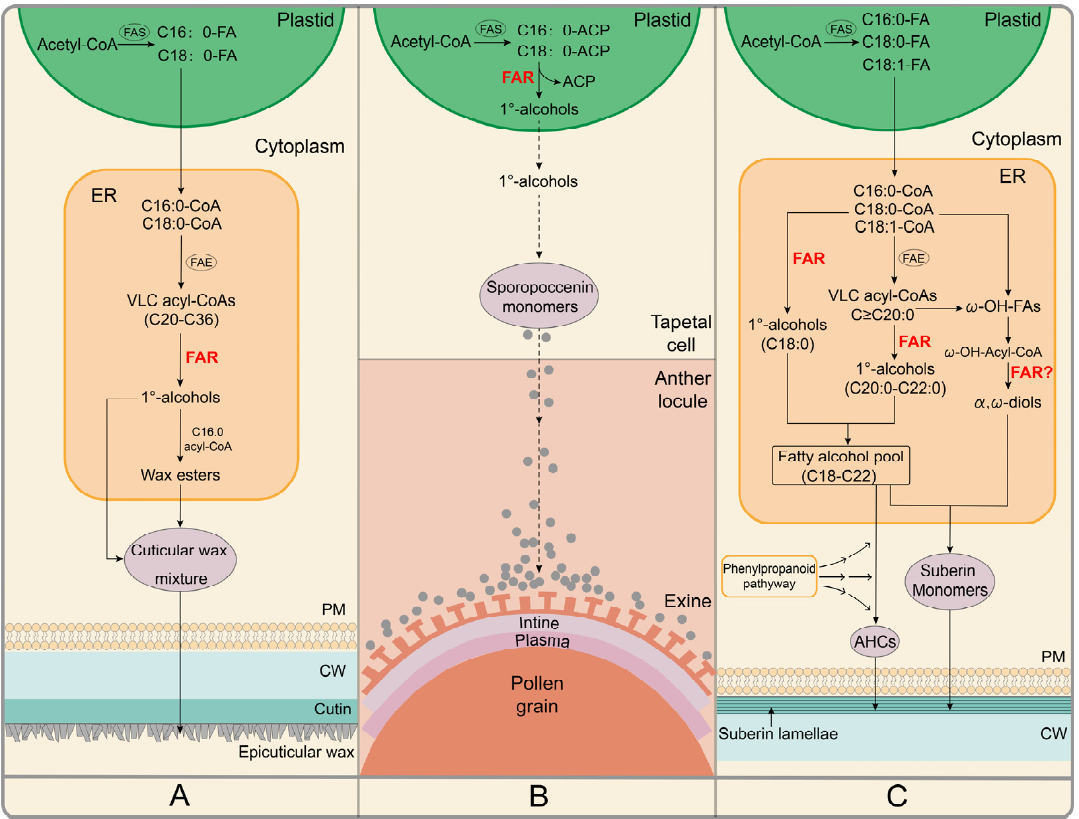
Figure 3. Pathways of FARs involved in lipid metabolism in the plant kingdom. ( A ) ER-Localized FARs are involved in the accumulation of cuticular waxes. The biosynthesis of waxes begins with C16 or C18 de novo fatty acid synthesis in the plastid. Then, utilizing C16 and C18 acyl-CoAs as substrates, the fatty acid elongase (FAE) complex performs a reiterative cycle to synthesize saturated VLCFAs. These VLCFAs are further modified into primary alcohols and wax esters. ( B ) Plasmid-Localized FARs are involved in sporopollenin biosynthesis. Acyl-ACPs synthesized de novo in the plastid are reduced by FAR to produce fatty alcohols. This product could then be exported to the anther locule by an unknown mechanism where it polymerizes at the surface of the microspore. ( C ) ER-Localized FARs are involved in the suberin and suberin-associated wax production. De novo fatty acid synthesis occurs in the plastid. Fatty acyl elongation occurs via the FAE complex producing VLCFAs. FARs catalyze acyl reduction to produce suberin monomer primary alcohols and α , ω -diols. Coumaric, caffeic, and ferulic acids produced by the phenylpropanoid pathway are linked to fatty alcohols by BAHD-type acyltransferases to produce alkyl hydroxycinnamates (AHCs). Abbreviations: PM, plasma membrane; CW, cell wall.